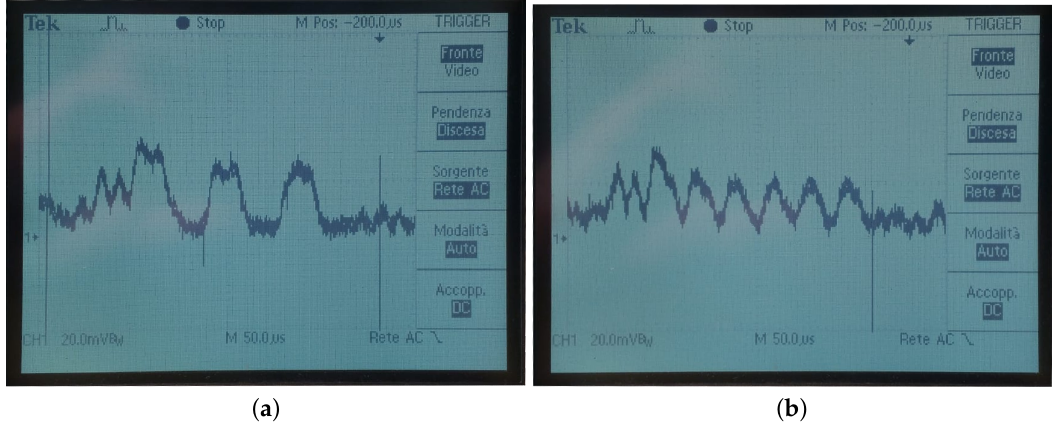
Figure 9. Microcontroller ADC input. ( a ) ‘0’; ( b )